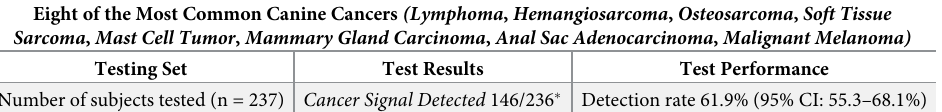
Table 7. Test results and performance in the testing set for eight of the most common canine cancers. Eight of the Most Common Canine Cancers (Lymphoma , Hemangiosarcoma , Osteosarcoma , Soft Tissue Sarcoma , Mast Cell Tumor , Mammary Gland Carcinoma , Anal Sac Adenocarcinoma , Malignant Melanoma) Testing Set Test Results Test